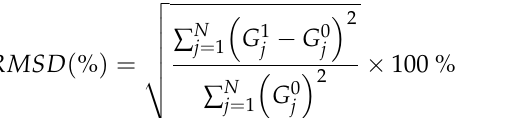
Figure 2. Experiment setup, ( a ) LCR meter and Vee-Pro platform, ( b ) setup for sensor bonded on the aluminum beam, and ( c ) oven used in the testing.